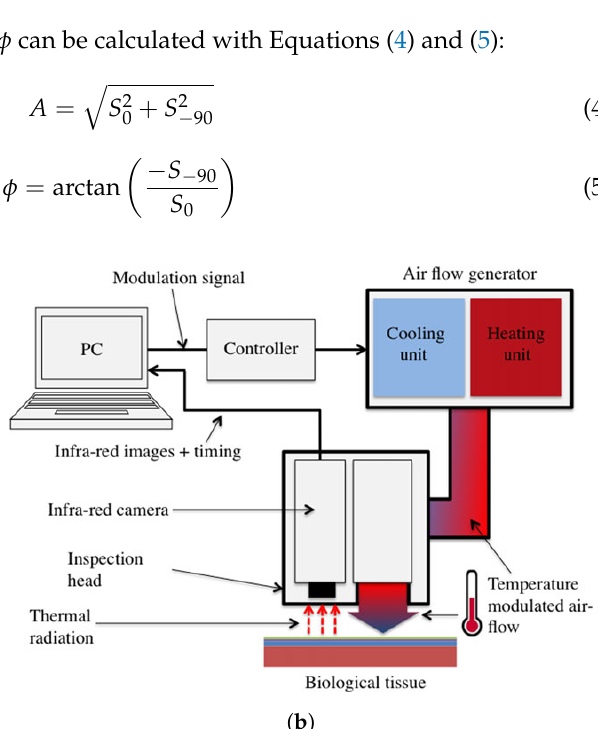
Figure 3. Lock-in ( a ) Lock-in device. Reprinted with permission from Ref. [62]. 2014, John Wiley & Sons A/S; ( b ) Description of lock-in setup. Reprinted with permission from Ref. [62]. 2014, John Wiley & Sons